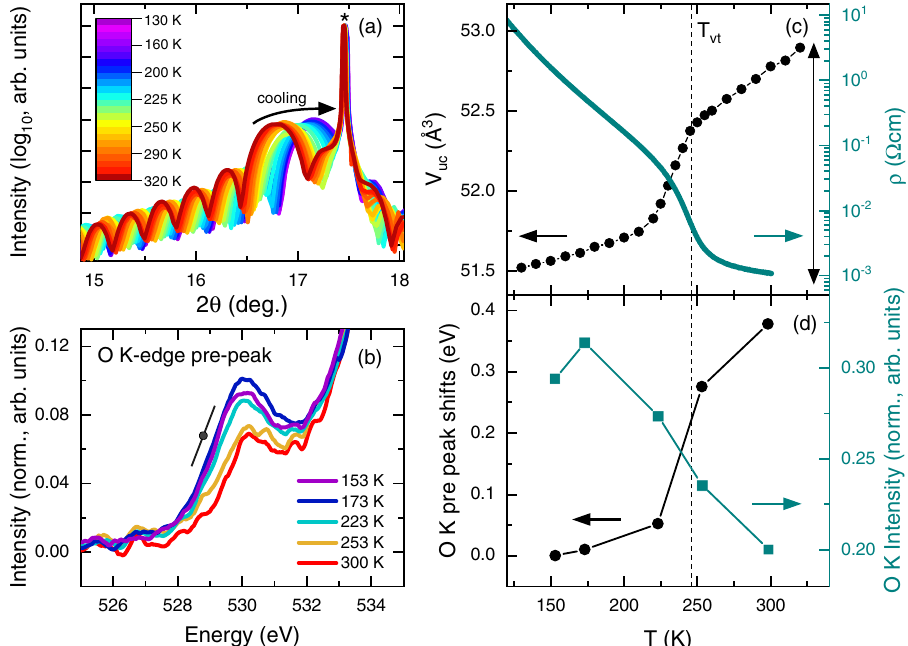
Fig. 5 | Temperature-dependent structural and valence transitions in compressively-strained (Pr 0.85 Y 0.15 ) 0.7 Ca 0.3 CoO 3- δ fi lms. ( a ) Temperature ( T )- dependent synchrotron X-ray diffraction (SXRD) around the 002 fi lmpeakof a 26- unit-cell-thick (Pr 0.85 Y 0.15 ) 0.7 Ca 0.3 CoO 3- δ fi lm on YAO(101) from 130K to 320K (see color scale). ( b ) Electron energy loss spectra (EELS) near the O K -edge pre-peak region of a ∼ 30-unit-cell-thick (Pr 0.85 Y 0.15 ) 0.7 Ca 0.3 CoO 3- δ fi lm on YAO(101) from 153K to 300K. The data are normalized to the post-edge intensity (580-585eV) to enabledirectcomparison. The black line illustrates the low- T slopewhilethe black point marks the low- T in fl ection point. This T -dependent in fl ection point was used todeterminethepre-peakshiftwith T ,asdescribedinmoredetailinFig.S7andthe